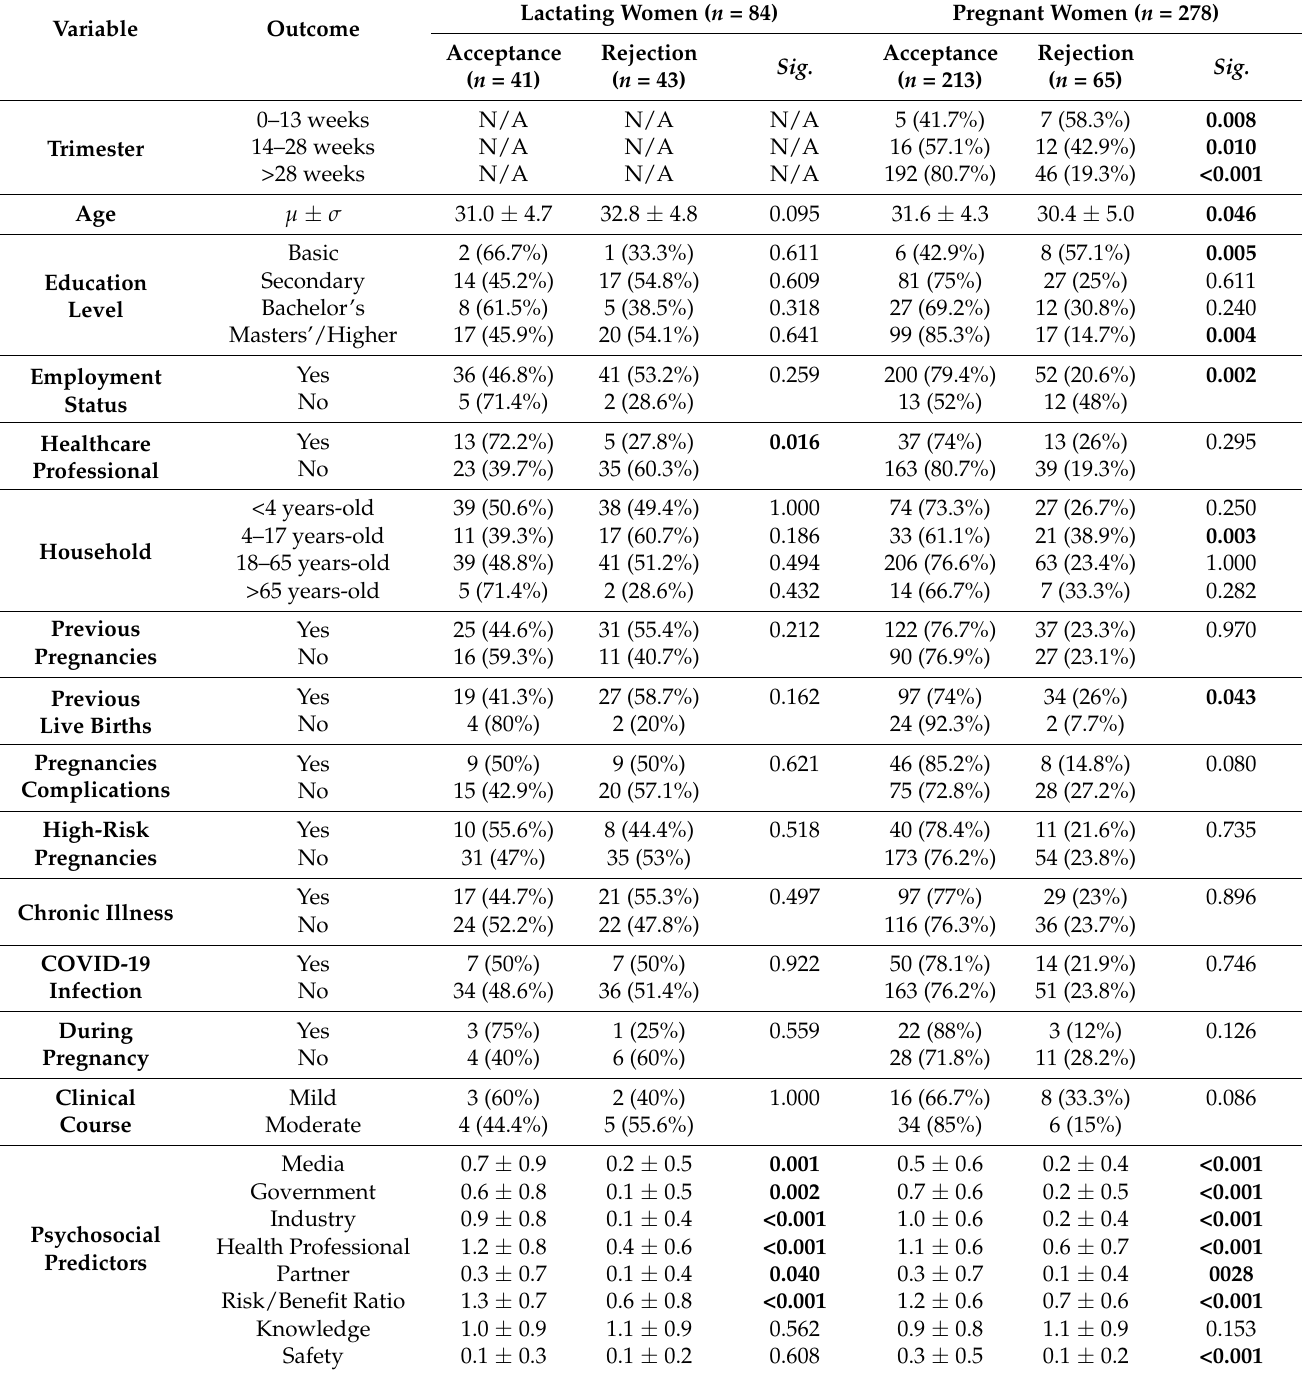
Table 7. Demographic, anamnestic and psychosocial risk factors of COVID-19 vaccine hesitancy among pregnant